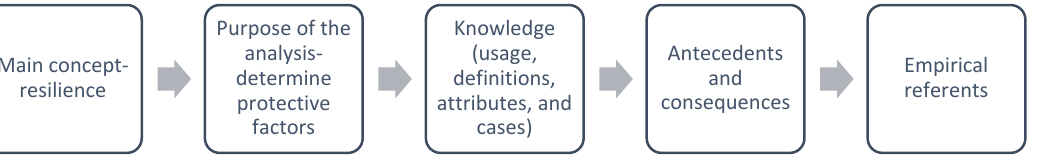
Figure 1. Main steps of the concept analysis of resilience in stroke patients. Data Sources